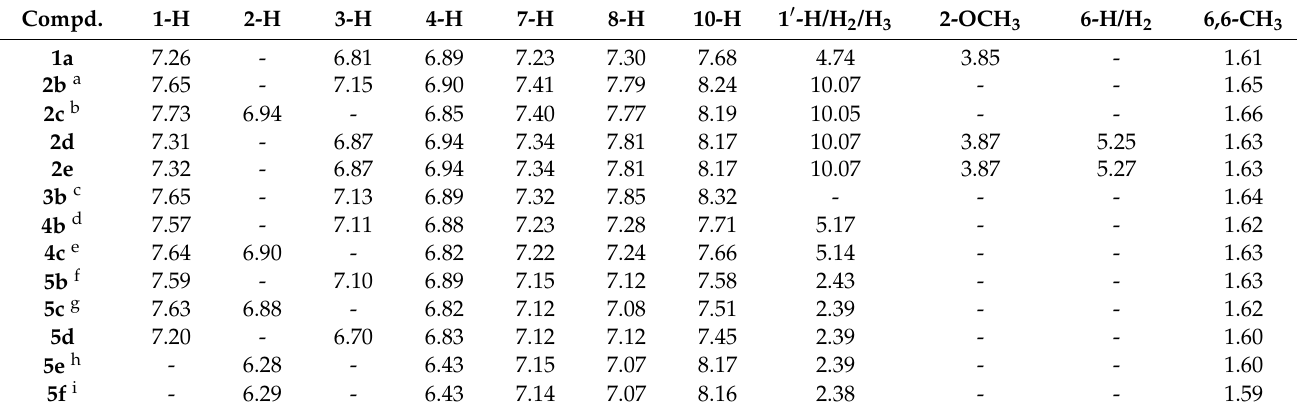
Table 2. Proton chemical shifts (in ppm) for the compounds prepared in this study, measured at 400 MHz. The assignments were made with 2D NMR spectroscopy, COSY, HMQC and HMBC experiments.